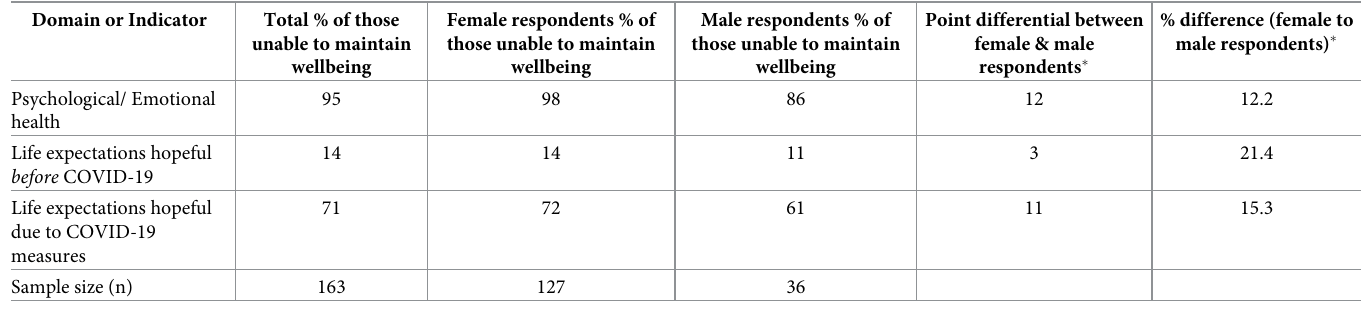
Table 6. Gender disparities in psychological & emotional health among South Australians unable to maintain wellbeing. Domain or